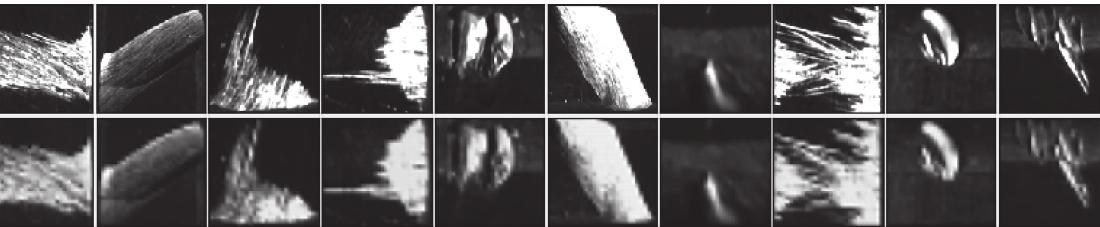
Figure 10: Reconstruction efficiency of the autoencoder.